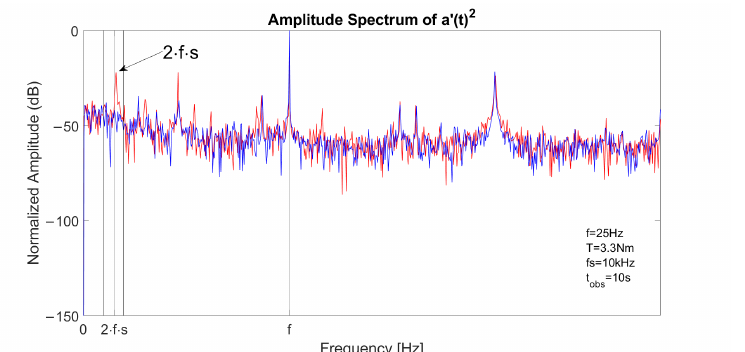
Figure 11. Spectrum of the square of the analytical signal a (cid:48) ( t ) 2 from experimental acquisition in healthy (blue) and faulty (red) conditions. The fault signature component is located at 2 sf